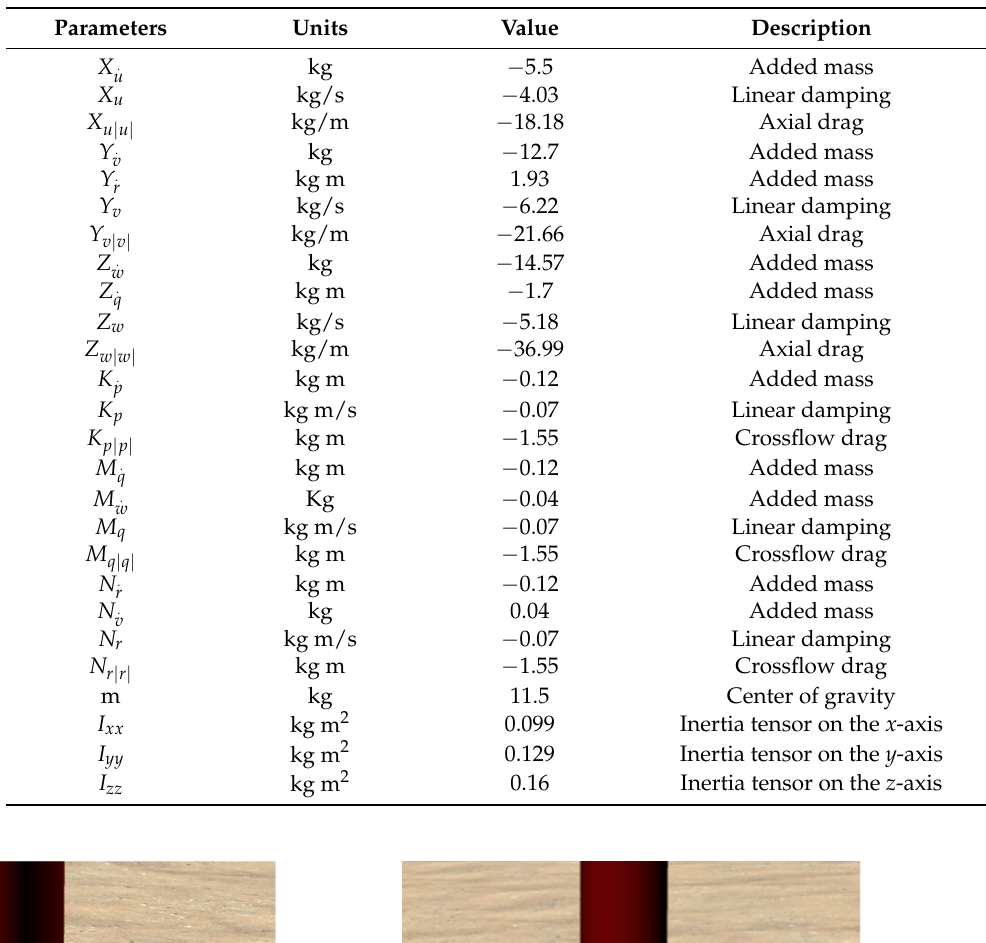
Table 1. Control parameters used in the simulation.